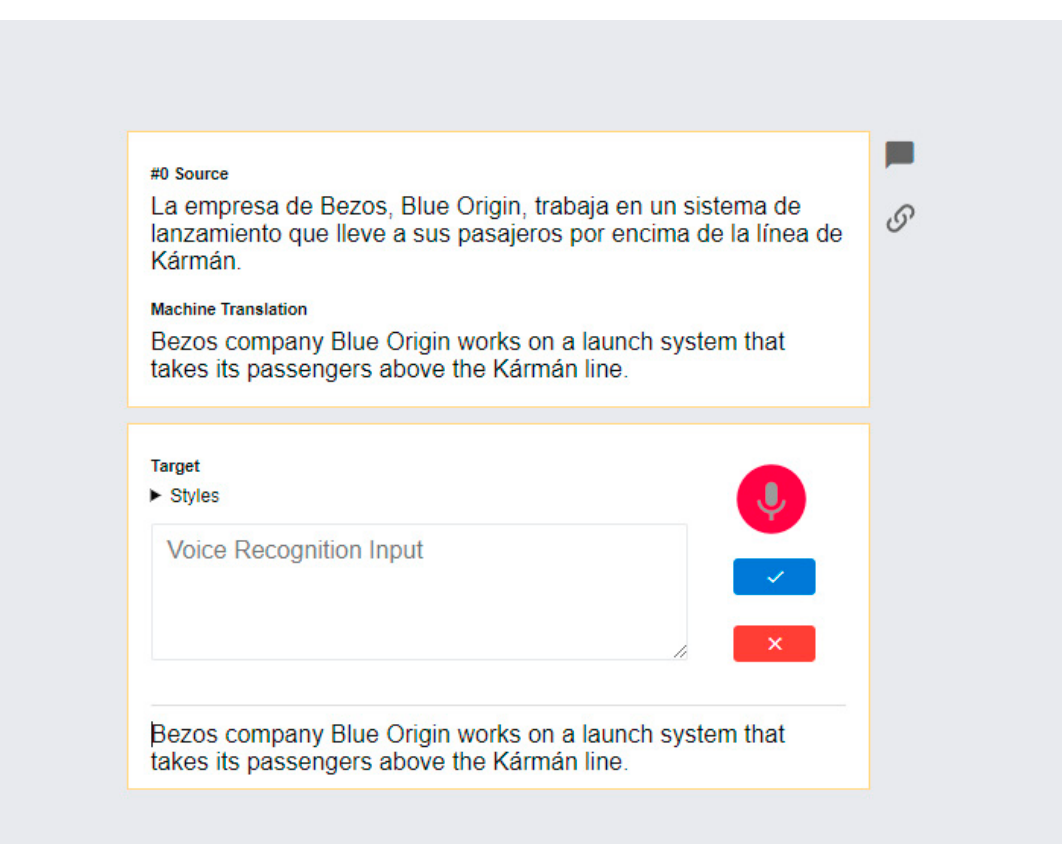
Figure 3. Interface of our initial prototype showing the Edit view with the dictation box active.